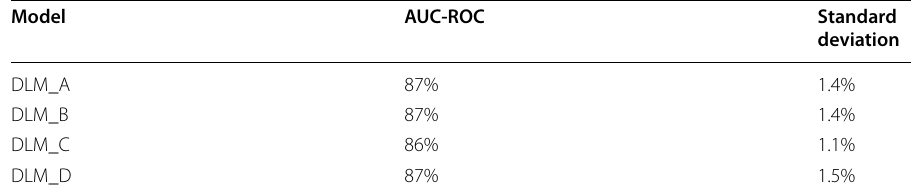
Table 13 Results: ten-fold cross